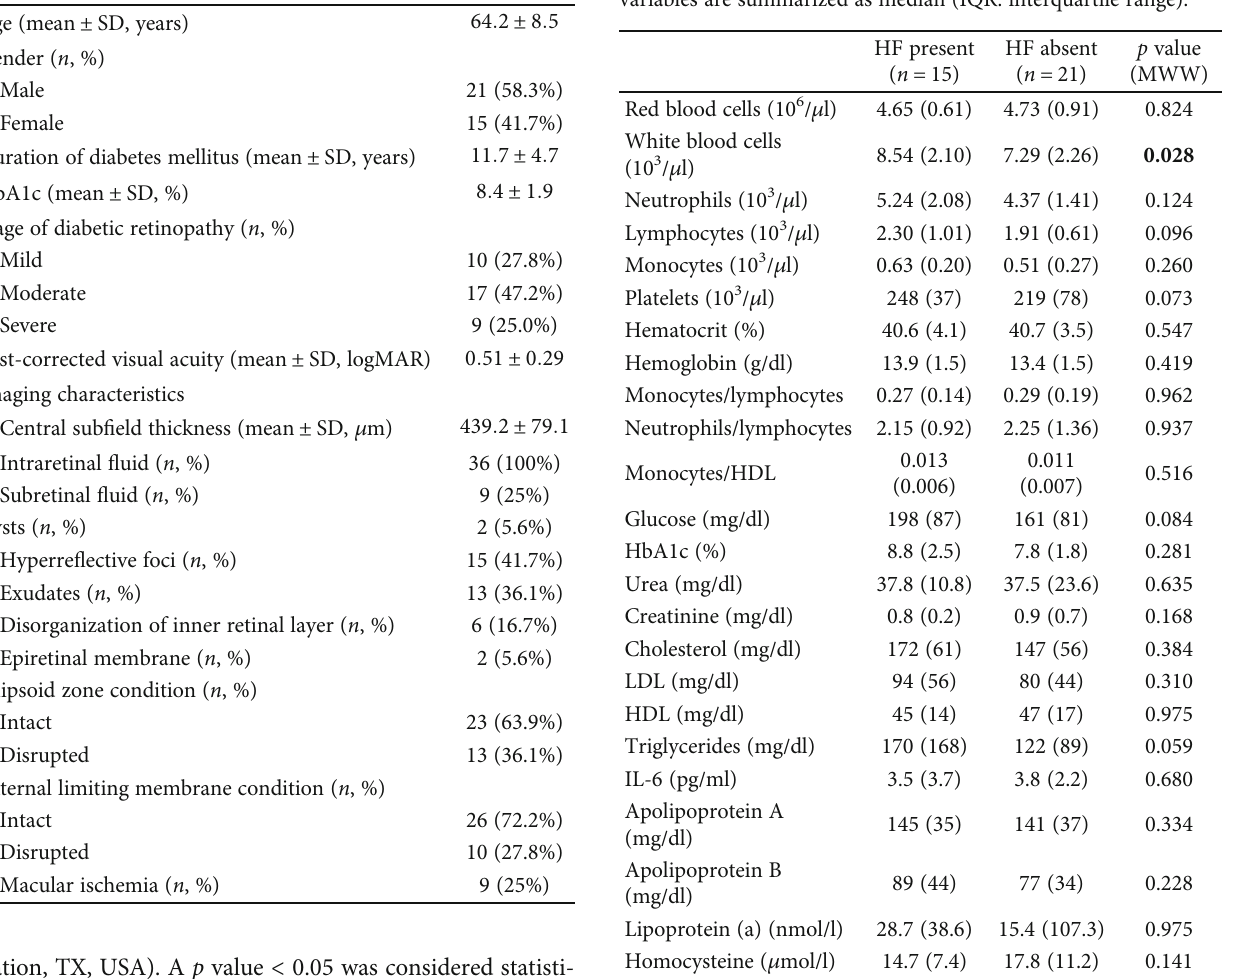
Table 1: Demographic and clinical characteristics of the study sample ( n = 36 patients with diabetic macular